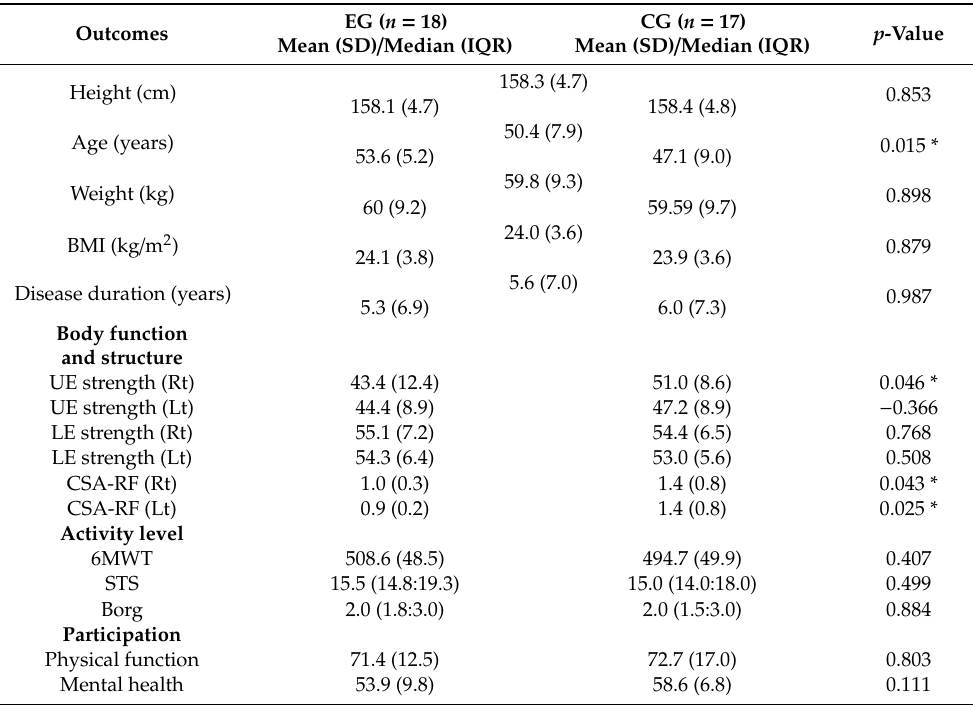
Table 2. Baseline demographics and clinical characteristics in the enrolled subjects.